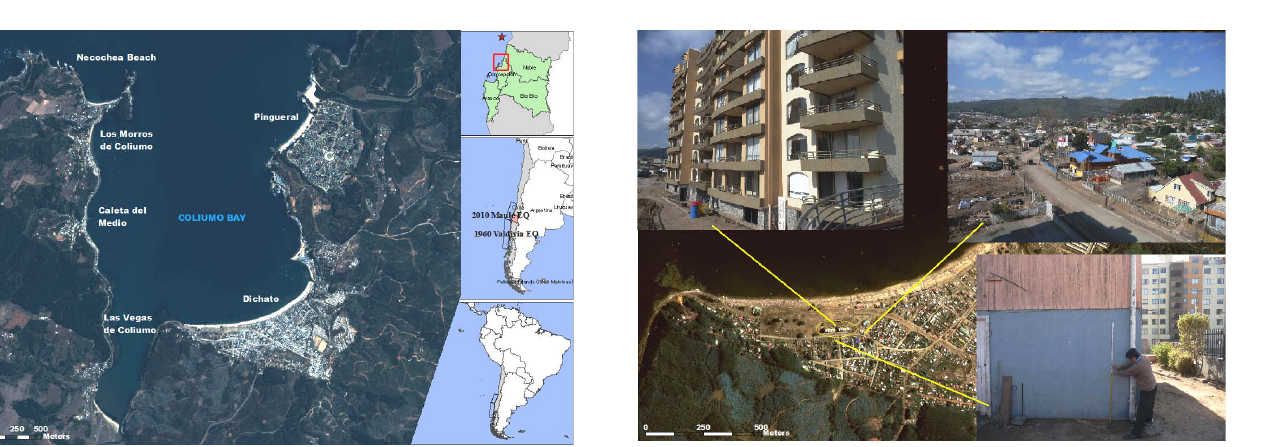
Fig. 1. Dichato is located in the Coliumo Bay of the B´ıo B´ıo region in Chile, around 80km south of the epicenter.